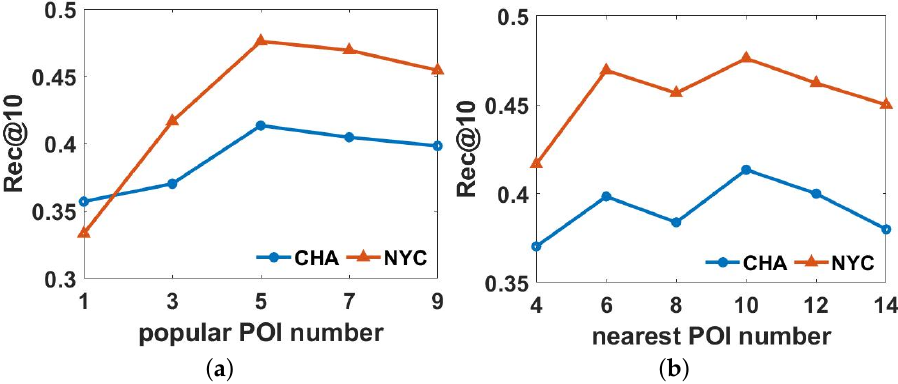
Figure 6. Performance of different hyperparameters on CHA and NYC datasets: ( a ) number of popular POIs; ( b ) number of nearest